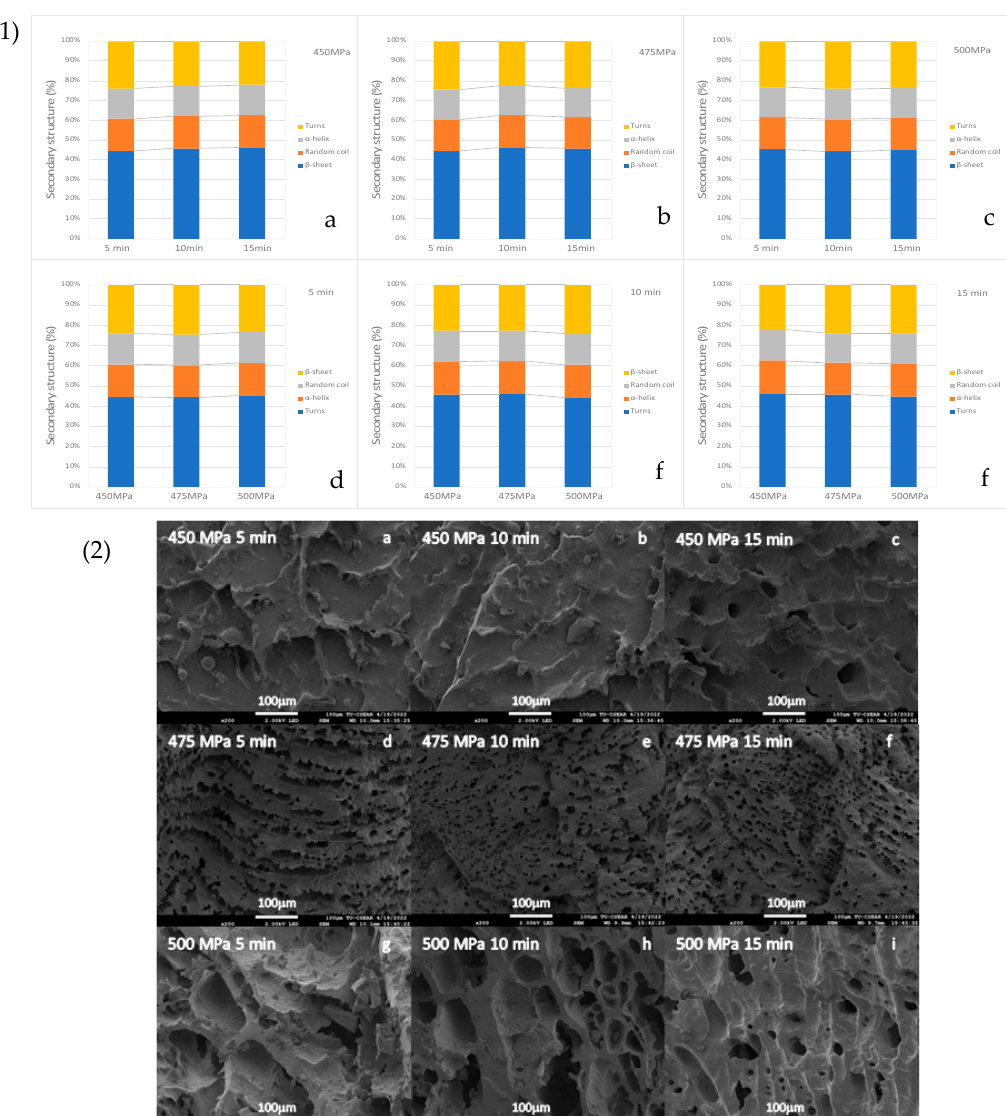
Figure 6. Effect of high-pressure and time on ( 1 ) the percentage of secondary: 450 MPa at 5, 10 and 15 min ( a ), 475 MPa at 5, 10 and 15 min ( b ), 500 MPa at 5, 10 and 15 min ( c ), 5 min at 450, 475 and 500 MPa ( d ), 10 min at 450, 475 and 500 MPa ( e ), 15 min at 450, 475 and 500 ( f ) and ( 2 ) the microstructure of protein of strawberry-flavoured egg-white pudding with 200 × magnification and 100 µ m scale bar: 450 MPa 5 min ( a ), 450 MPa 10 min ( b ), 450 MPa 15 min ( c ), 475 MPa 5 min ( d ), 475 MPa 10 min ( e ), 475 MPa 15 min ( f ), 500 MPa 5 min ( g ), 500 MPa 10 min ( h ), and 500 MPa 15 min ( i ).